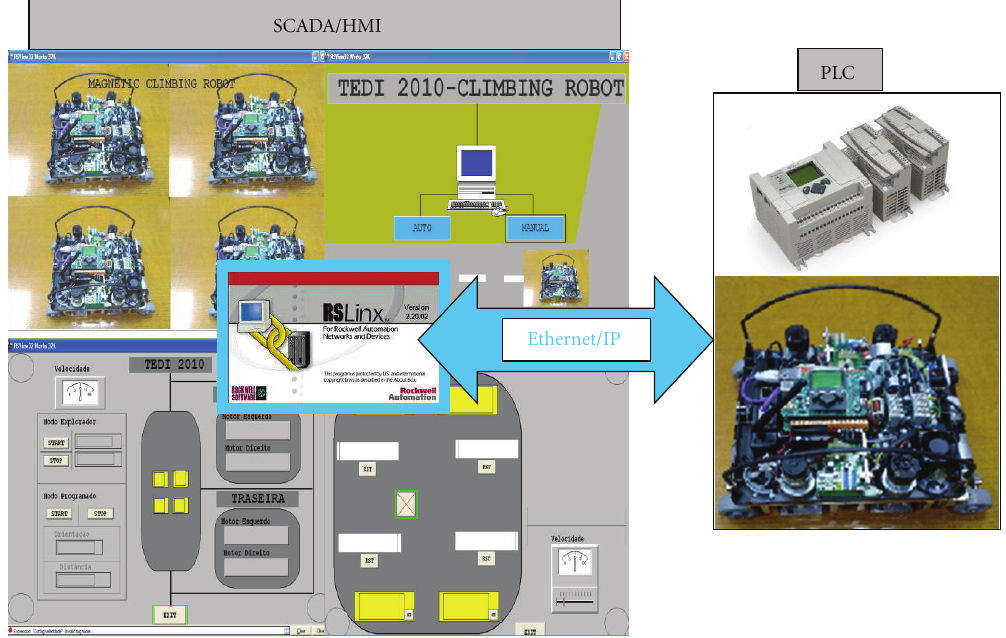
Figure 12: Prototype climbing robot supervision (SCADA-RSView32), from a remote